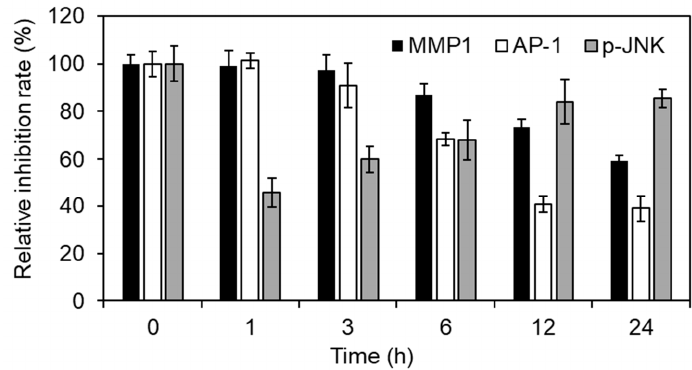
Figure 5. JNK-AP-1 axis mediated MMP1 mRNA regulation of Inonotus obliquus extracts in human dermal fibroblasts. MMP1 mRNA, AP-1 activity and p-JNK was shown in time course. The relative inhibition rate (%) was evaluated by [1-(200 µ M H 2 O 2 -and Inonotus obliquus extracts co-treated cells / 200 µ M H 2 O 2 -treated cells)] × 100.